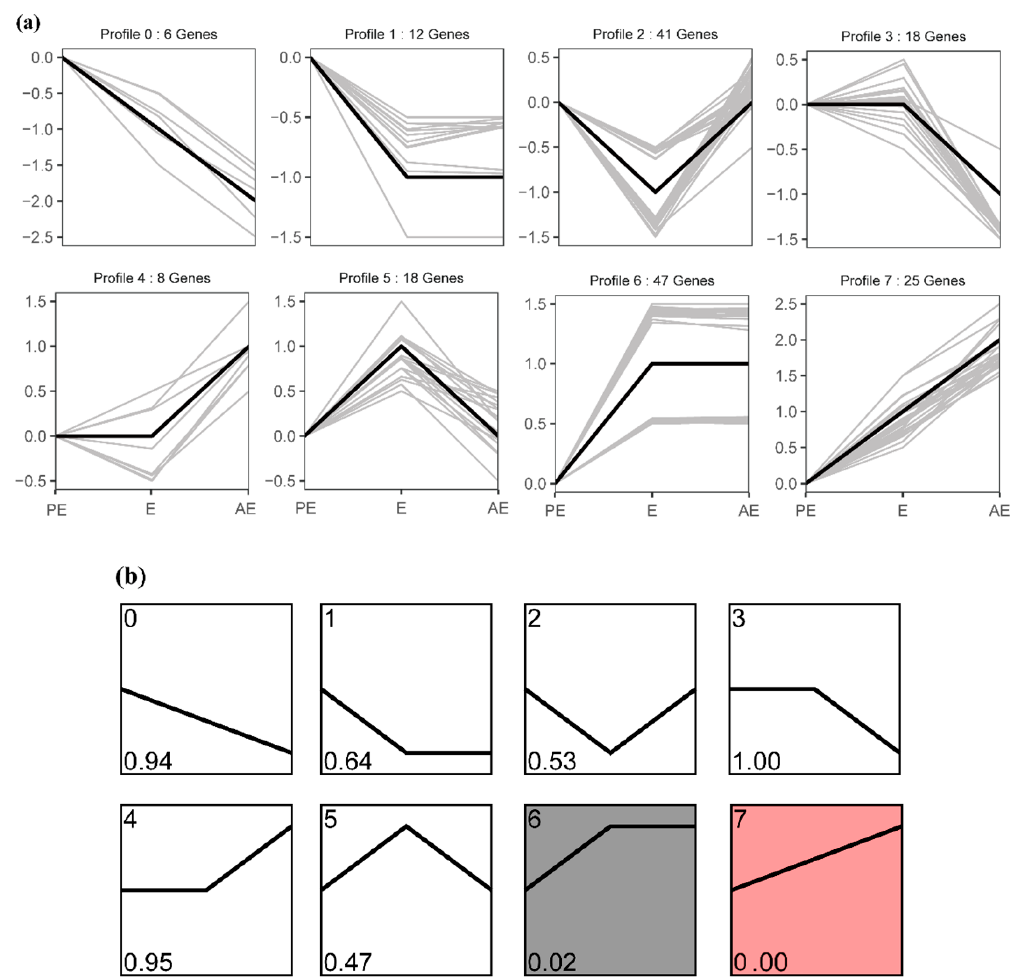
Figure 3. Analysis on the expression trend of salivary protein in the estrus cycle of Large White sows. ( a ) Overview of all trends. ( b ) Profiles ordered based on the p value significance of the number of genes assigned versus expected.